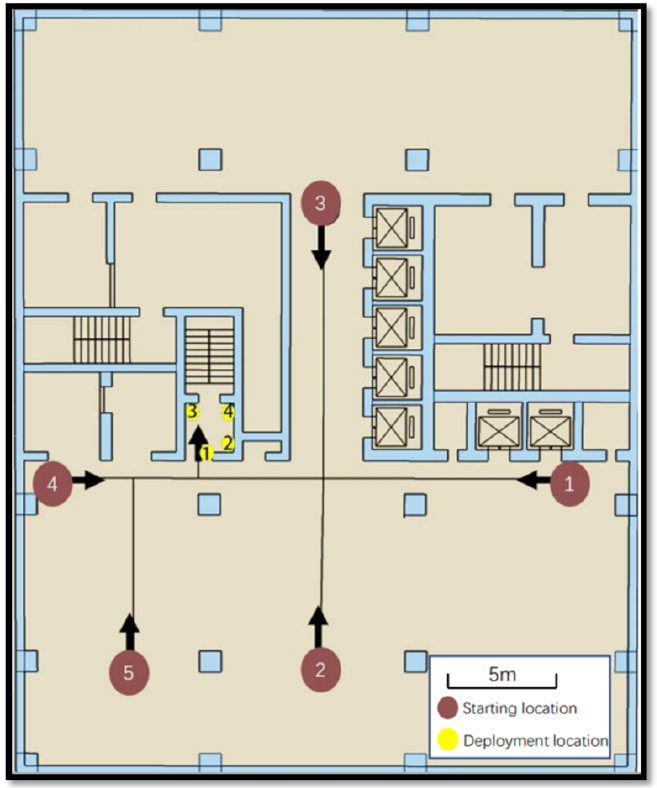
Figure 5. The floor plan of the experiment